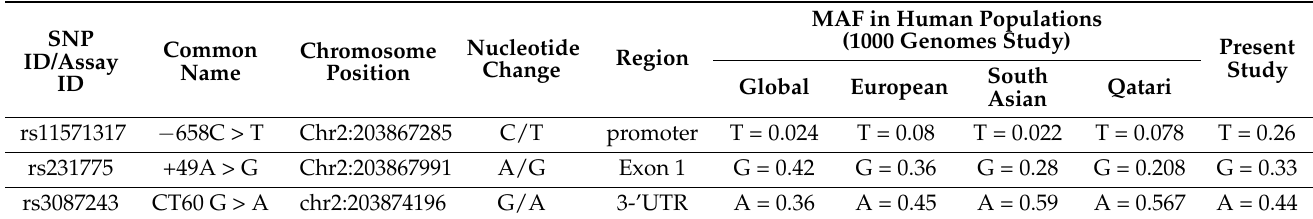
Table 2. Characteristics of selected polymorphisms involved in the CTLA-4 gene.